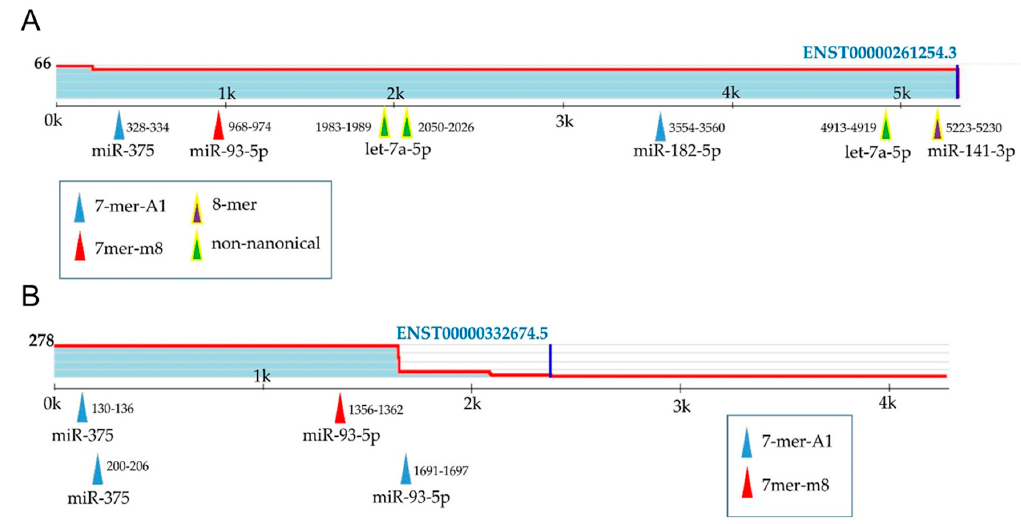
Figure 6. Predicted miRNA binding sites in the human CCND2 3 ′ UTR (NG_034254.1) ( A ) and MXI1 (NG_012103.1) ( B ) were determined using TargetScan.org [67]; 8mer, an exact match to positions 2–8 of the mature miRNA followed by an ‘A’; 7mer-m8, an exact match to positions 2-8 of the mature miRNA; 7mer-A1, an exact match to positions 2–7 of the mature miRNA followed by an ‘A’;